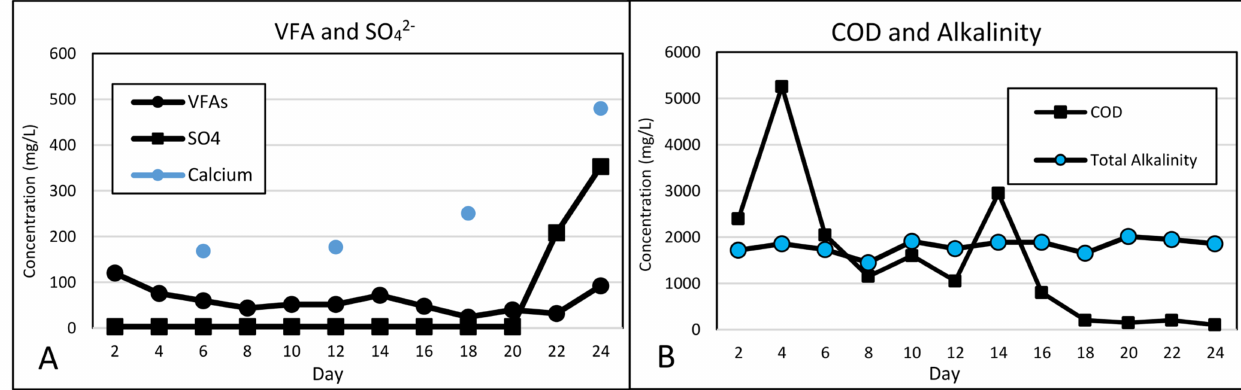
Figure 8. Treated COD, alkalinity, VFA, and SO4 2 − : ( A ) Results for VFA, SO4 2 − , Ca, ( B ) Results for COD and total